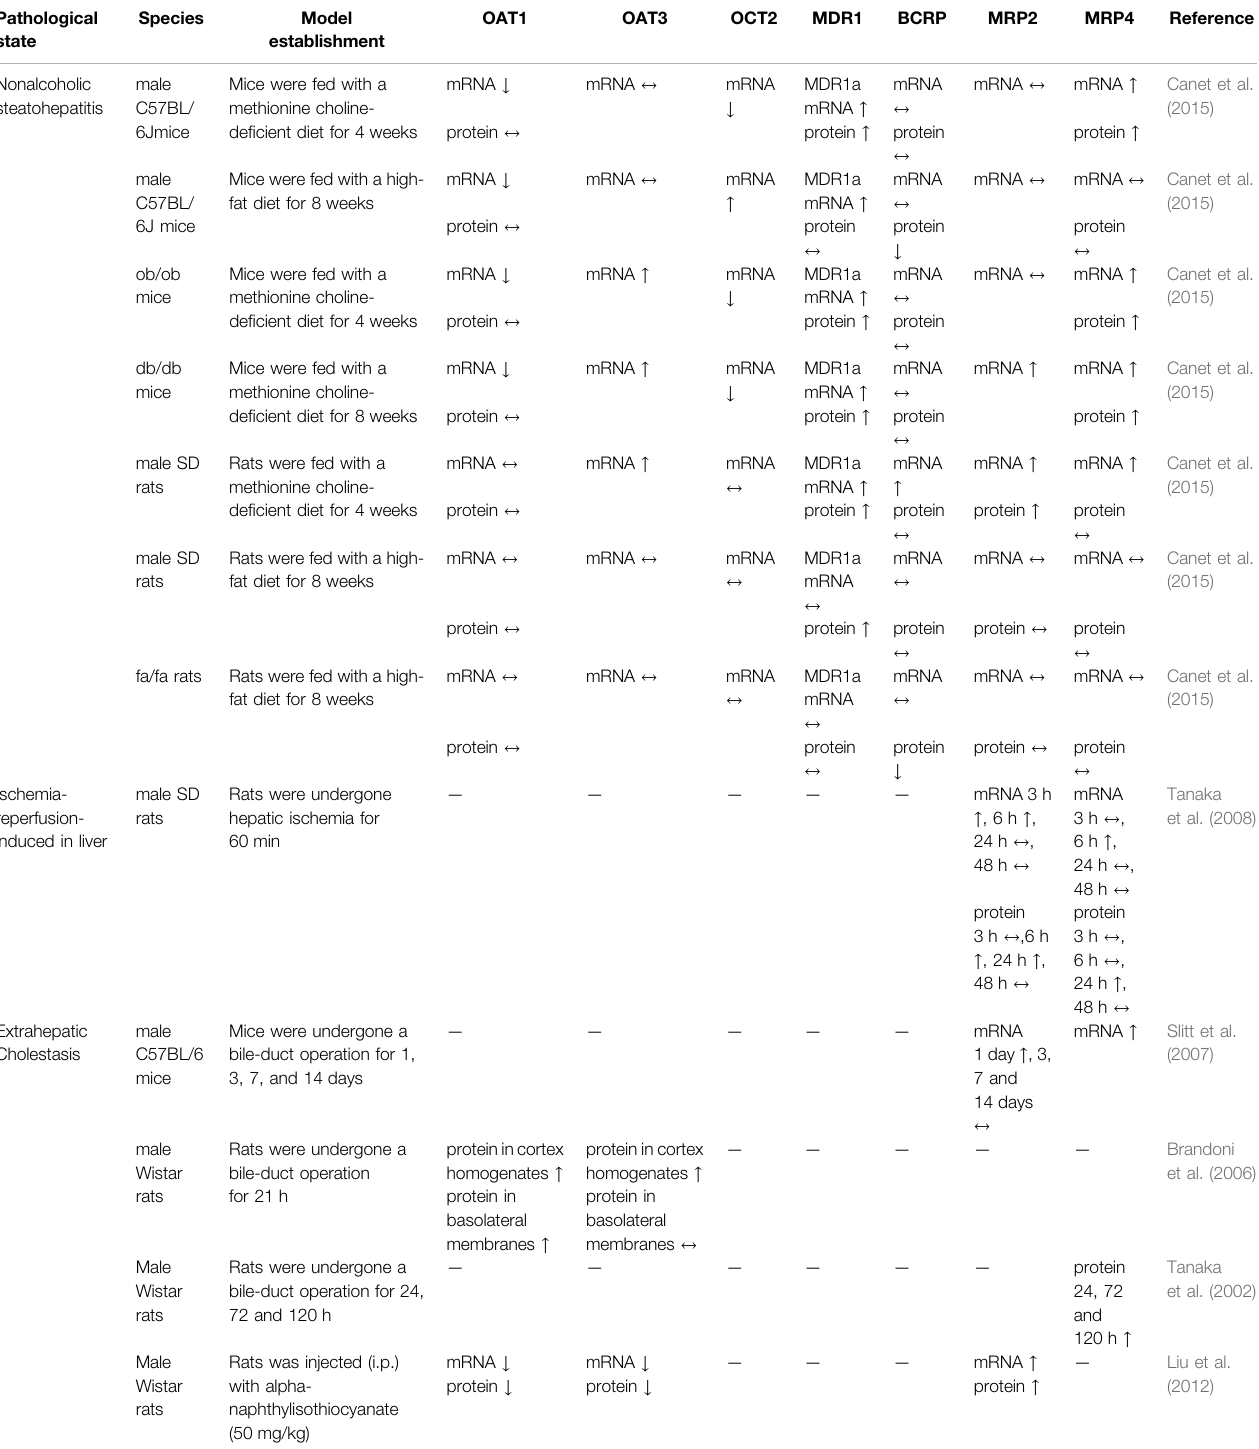
TABLE 4 | The changes of main drug transporters in liver and gallbladder related diseases on mRNA and/or protein levels. Pathological state Nonalcoholic steatohepatitis